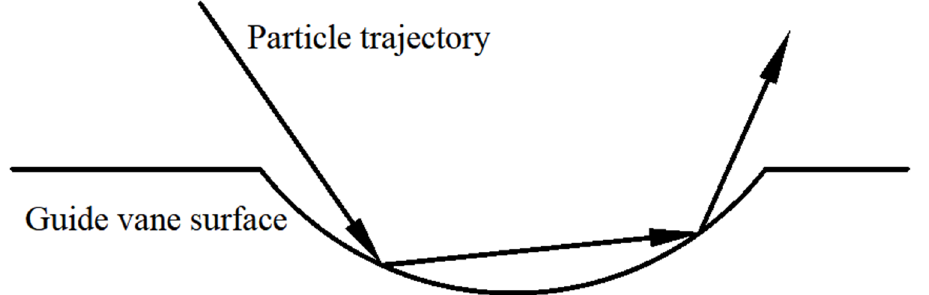
Figure 17. Trajectory diagram of sediment particles. Table 3. Weighing of guide vane specimens before and after wear.